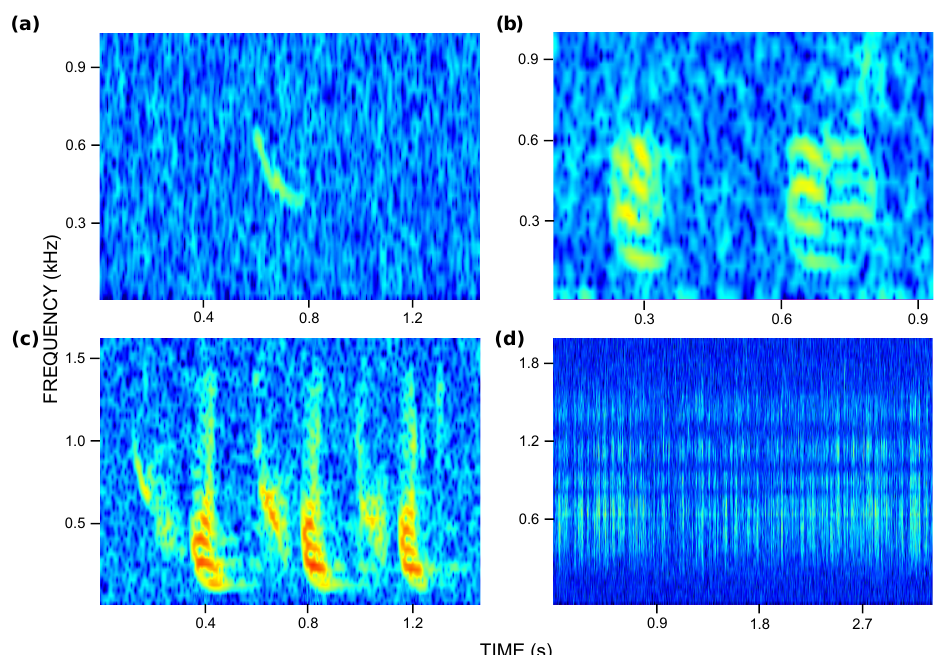
Figure 5. Underwater sounds produced by ringed seals: ( a ) yelp, ( b ) bark, ( c ) alternating series of yelps and barks, and ( d ) digging of a hole in the ice.